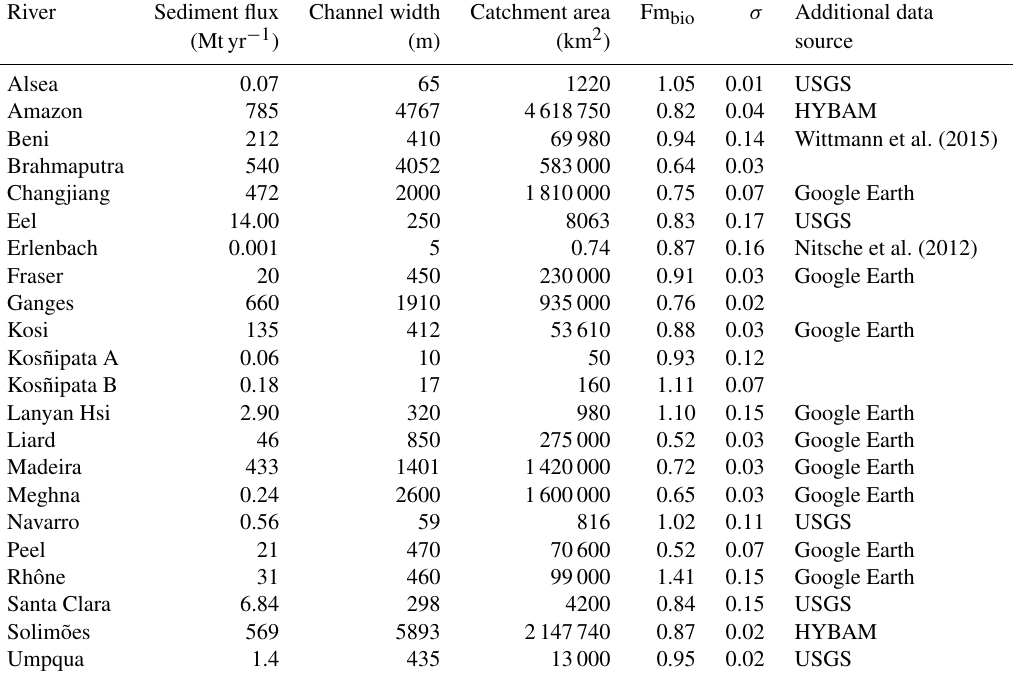
Table 2. Physical characteristics and inferred biospheric Fm values for a subset of rivers in the radiocarbon compilation. The values of sediment fluxes are taken from the original studies and are based on either suspended sediment gauging or cosmogenic nuclide concentrations. We report the uncertainty on our estimate of biospheric Fm using Eq. (13) as 1 standard deviation ( σ